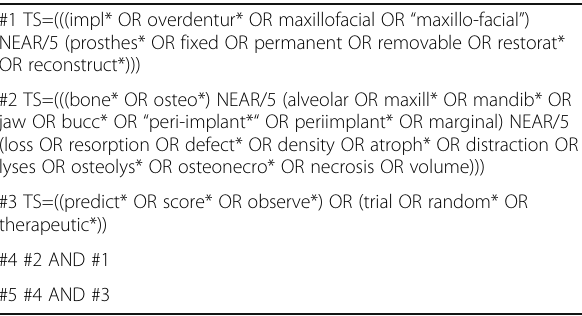
Table 1 Electronic free-text term search in Web of